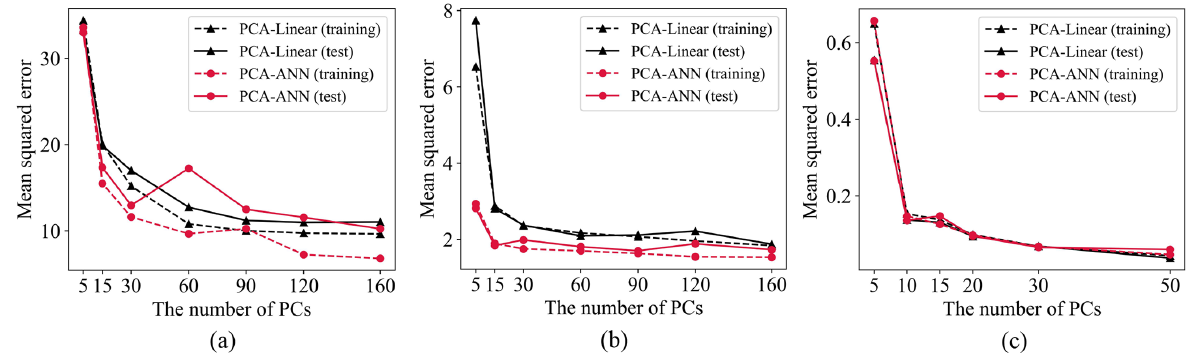
Figure 5. Loss function with the different number of PCs of the PCA-ANN (red) and PCA-Linear (black) models for spectral replacement with training and test datasets for Defects 1–3 ( a : Defect 1; b : Defect 2; c : Defect 3). The number of hidden nodes for ANN is double the number of PCs.